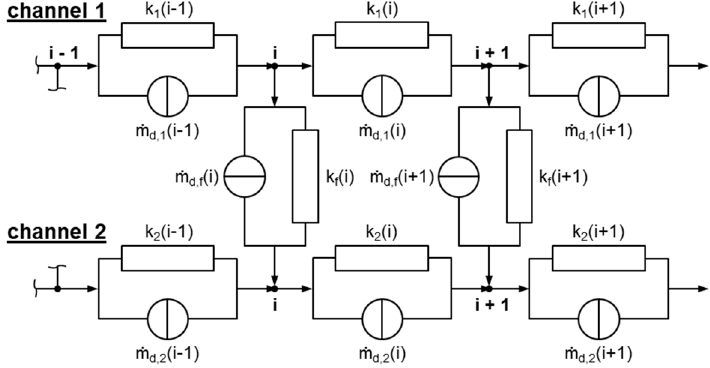
Figure 11. Equivalent circuit diagram.